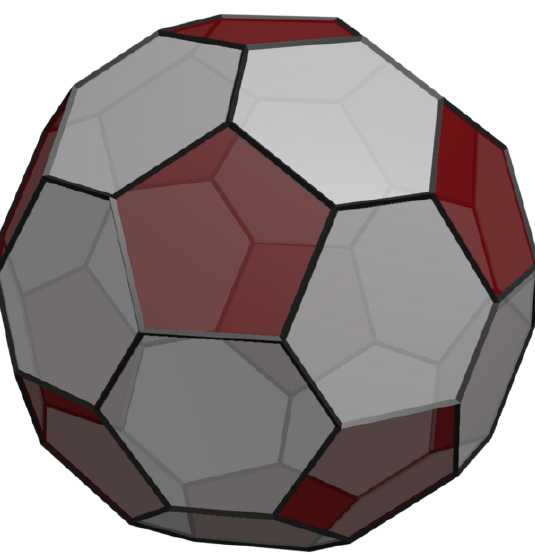
Figure 2: A "soccer ball" made from hexagons and pentagons. 12 pentagons are needed to absorb the curvature of the